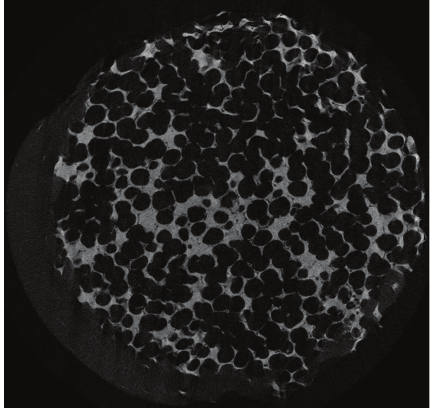
Figure 1: Microstructure of the HA orbital implant. A planar reconstruction of a native 18mm-diameter HA orbital implant. Acquisition performed with microCT applying 7.815 micrometer voxel size (SkyScan, Kontich, Belgium).